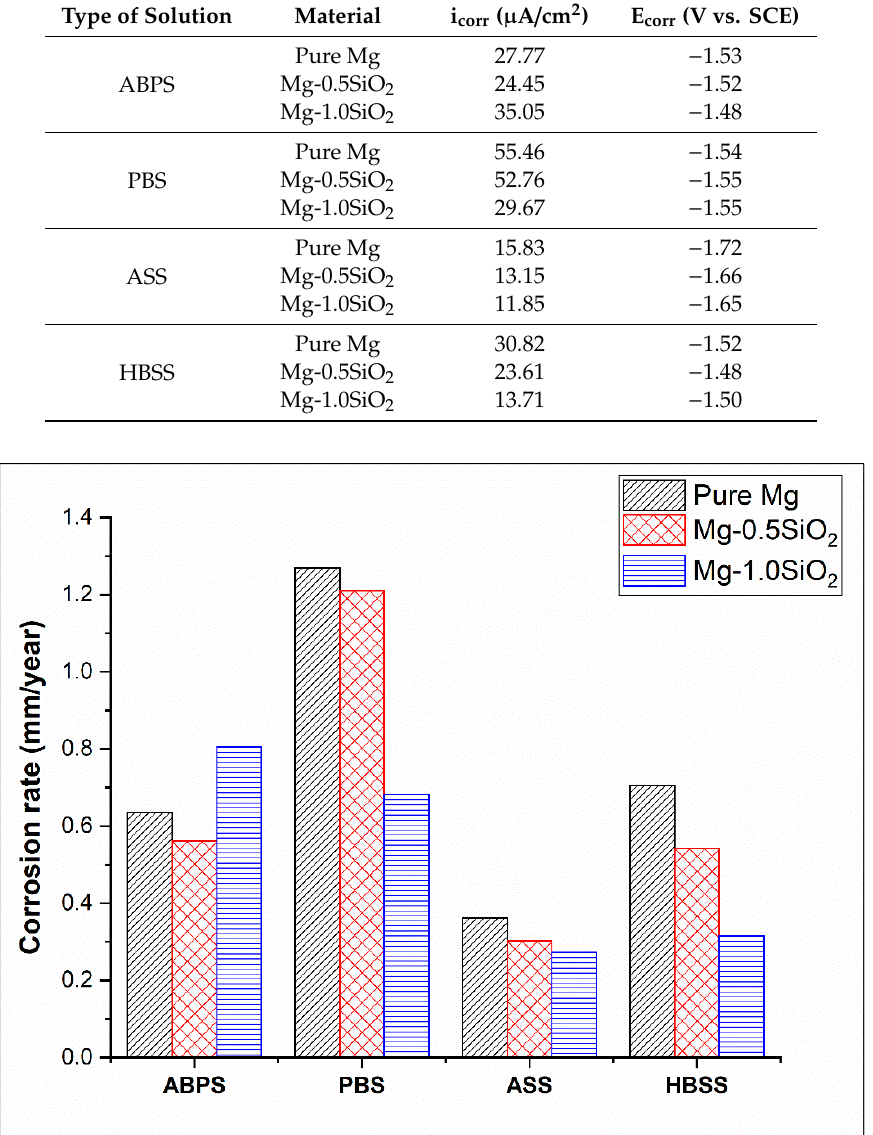
Figure 4. Corrosion rate in Mg-SiO 2 syntactic foams in SBFs.